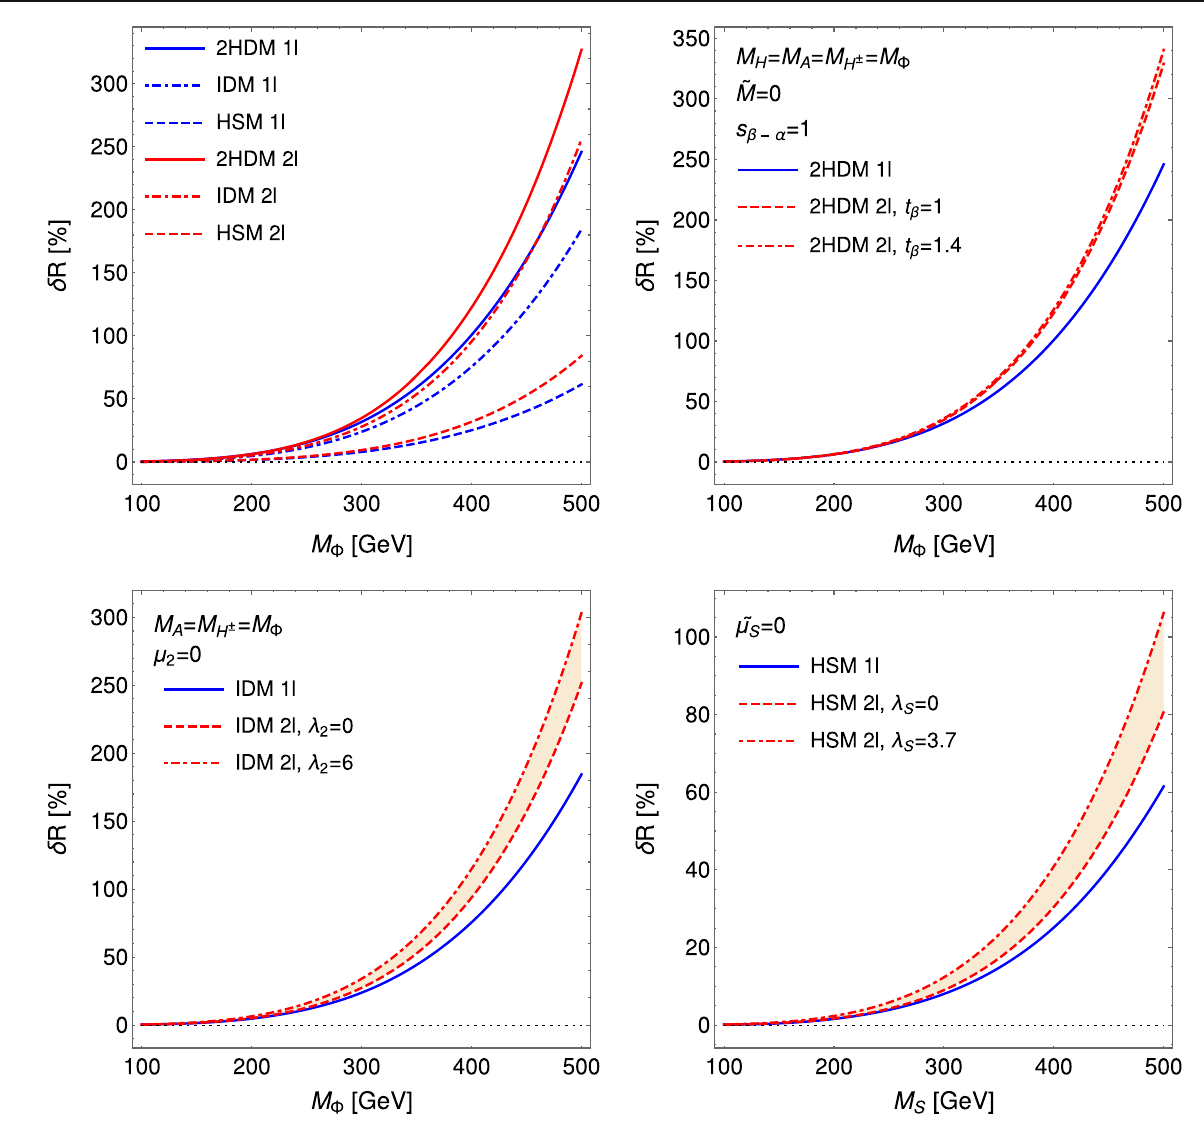
Fig. 8 Illustration of the non-decoupling behaviour of the BSM cor- rections to the Higgs trilinear coupling ˆ λ hhh , at one and two loop(s). ( Upper left ): Comparison of the results for δ R in the 2HDM (solid), the IDM (dot-dashed), and the HSM (dashed) at both one-loop (blue) and two-loop (red) orders, as a function of the degenerate mass M Φ of all BSM scalars. We also choose: tan β = 1 . 1 for the 2HDM; λ 2 = 0 . 5 for the IDM; and λ S = 0 . 5 for the HSM. ( Upper right ): Non-decoupling behaviour of the BSM effects in the 2HDM as a function of M Φ , at one loop (blue) and two loops (red). At two-loop order, the two curves correspond to tan β = 1 (dashed) and tan β = 1 . 4 (dot-dashed), the